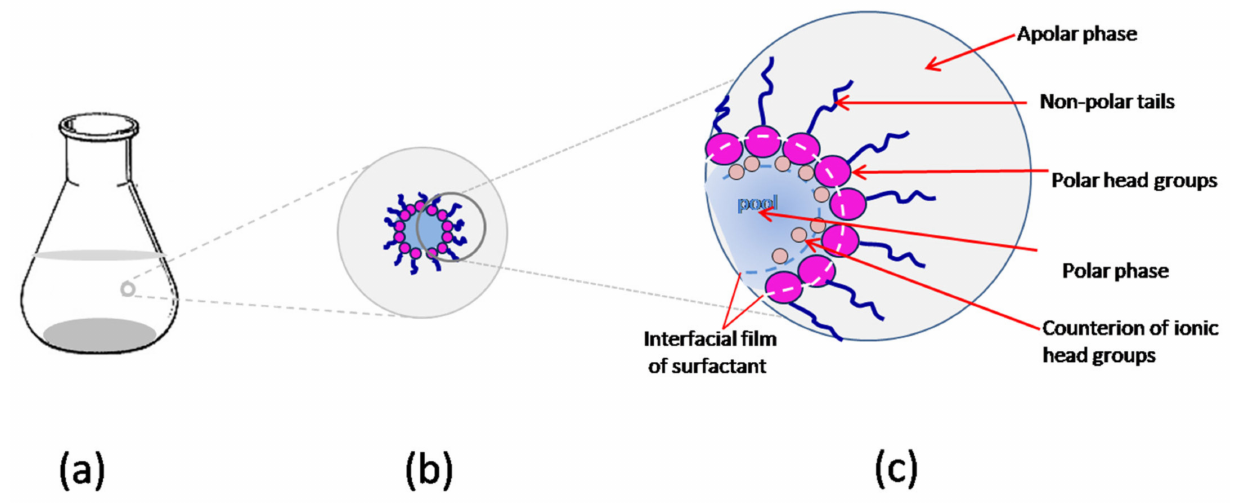
Figure 5. Schematic representation of RMs at different levels: ( a ) macroscopic; ( b ) microscopic; ( c )